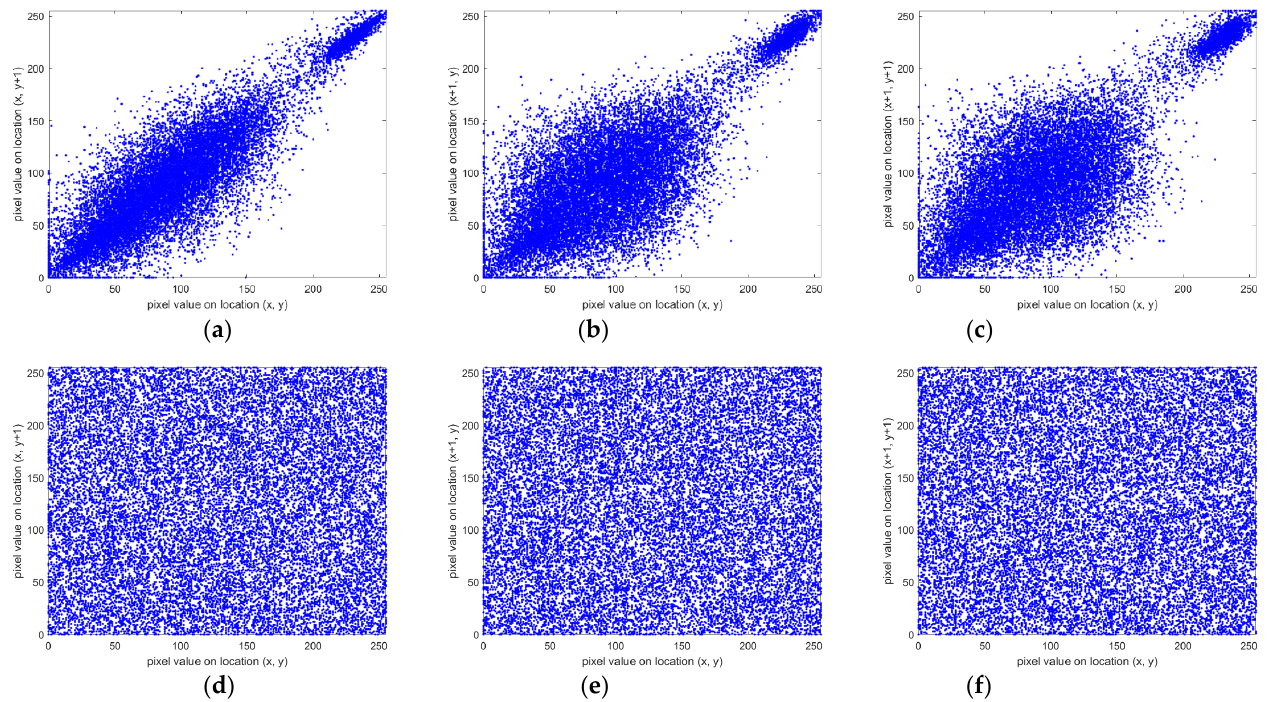
Figure 19. Blue-component Adjacent pixel correlation of Baboon and corresponding cipher image: ( a ) Horizontal direction; ( b ) Vertical direction; ( c ) Diagonal direction; ( d ) Horizontal direction; ( e ) Vertical direction; ( f ) Diagonal direction. Table 17. Correlation coefficient values of adjacent pixels.